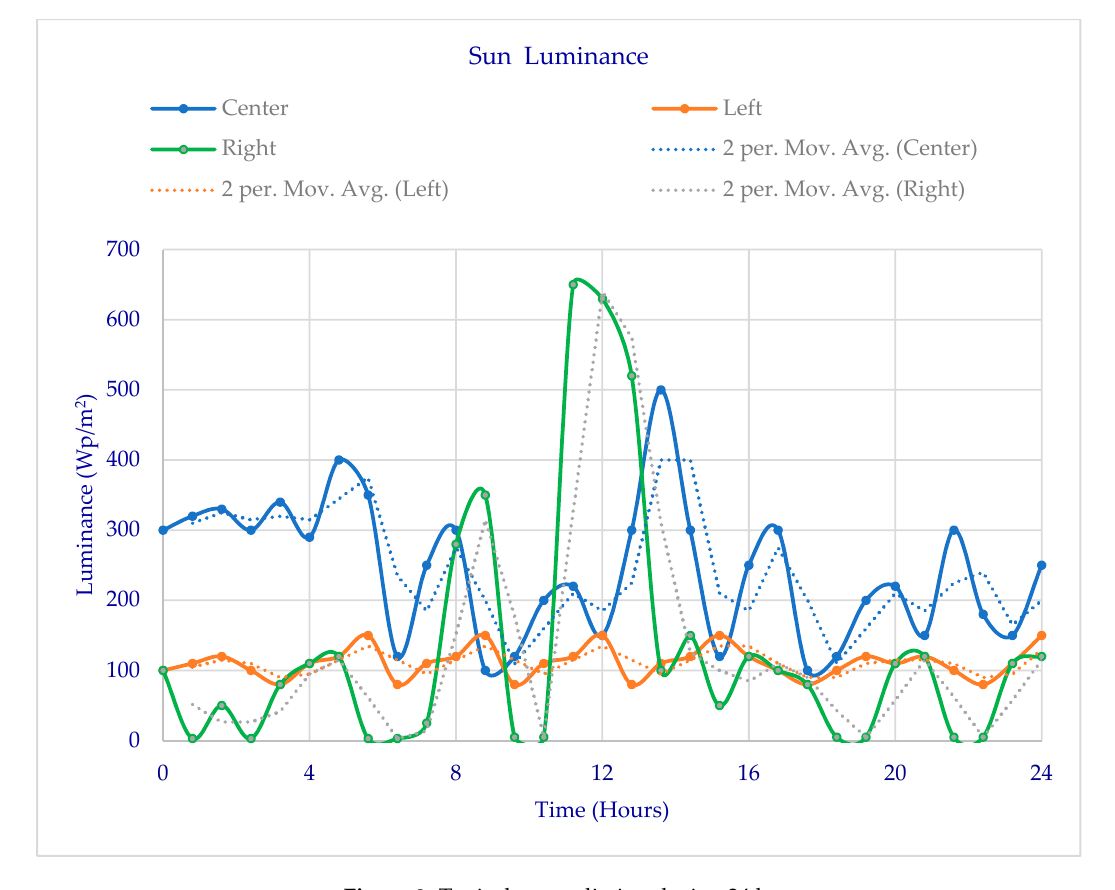
Figure 3. Typical sun radiation during 24 h.